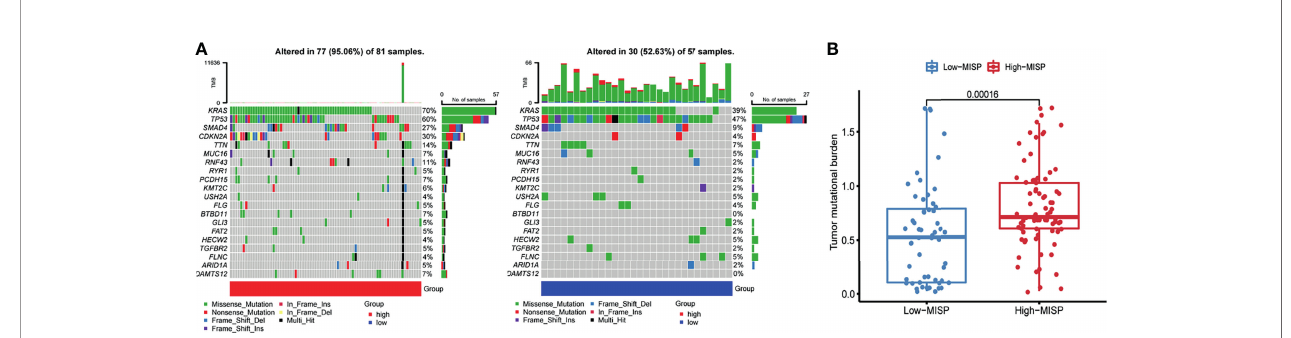
FIGURE 4 | Mutation pro fi le and TMB of PAAD samples from TCGA database. (A) Waterfall plot of mutation pro fi les of each gene in each sample in high- and low- MISP group. The legend at the bottom described the mutation types. The plot above the legends showed the mutation burden of each sample. (B) TMB in high- and low- MISP